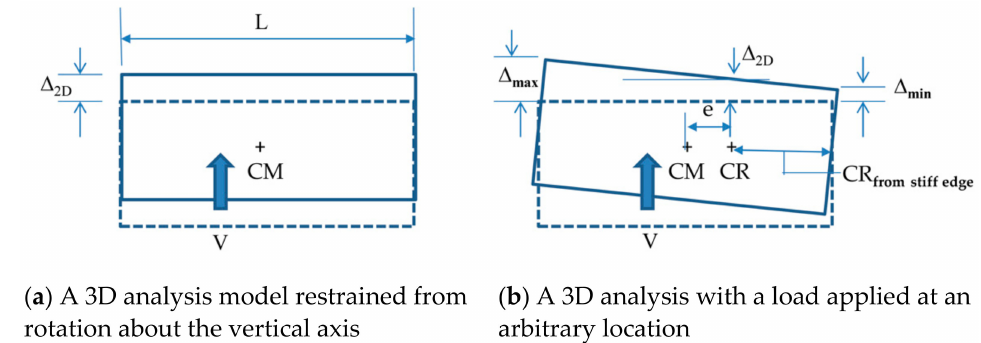
Figure 3. Method 1 of locating the centre of rigidity (CR) based on analysis of torsionally restrained and unrestrained building